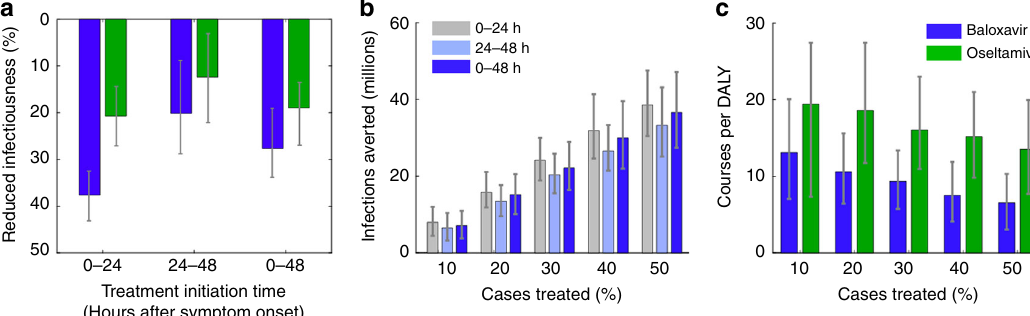
Fig. 4 Public health impacts of expanding and accelerating antiviral treatment. a The estimated overall reduction in infectiousness in a treated individual resulting from antivirals, depending on the timing of their fi rst dose after symptom onset. Values are areas between the log viral titer curves shown in Fig. 2 for untreated and treated cases. The 0 – 48 h treatment window assumes treatment times follow the distribution reported in the recent clinical trial 8 (Table 1); the 0 – 24 and 24 – 48 h treatment windows use compressed versions of the 48 h empirical distribution. The heights of the columns and error bars indicate median values and interquartile ranges, respectively, across 100 stochastic simulations for each treatment window. b Total infections averted by treating the indicated percent of cases with baloxavir within 24 h, between 24 and 48 h, and within 48 h of symptom onset. For each treatment window, we compress the empirical 48-hour distribution of antiviral administration times. c The number of courses of treatment per DALY averted resulting from treating the indicated percent of cases with either baloxavir or oseltamivir within 48 h of symptom onset. For both graphs, the height and error bars indicate medians and interquartile ranges across n = 1000 independent pairs of simulations (baseline vs. treatment scenarios) of the fi tted 2017 – 2018 model.